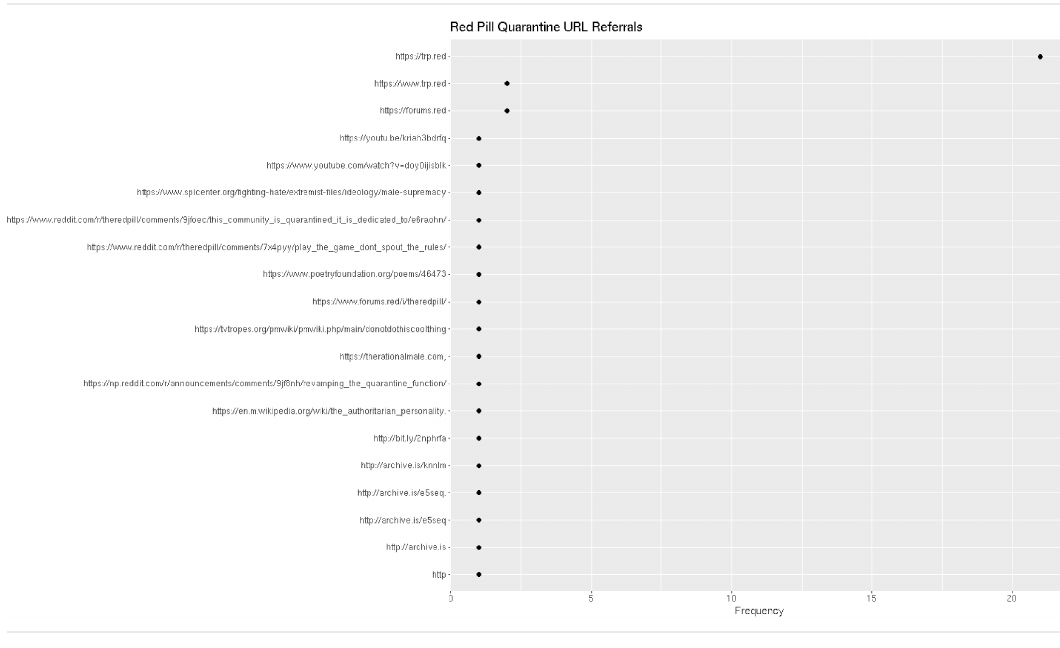
FIGURE 5: Red pill quarantine url